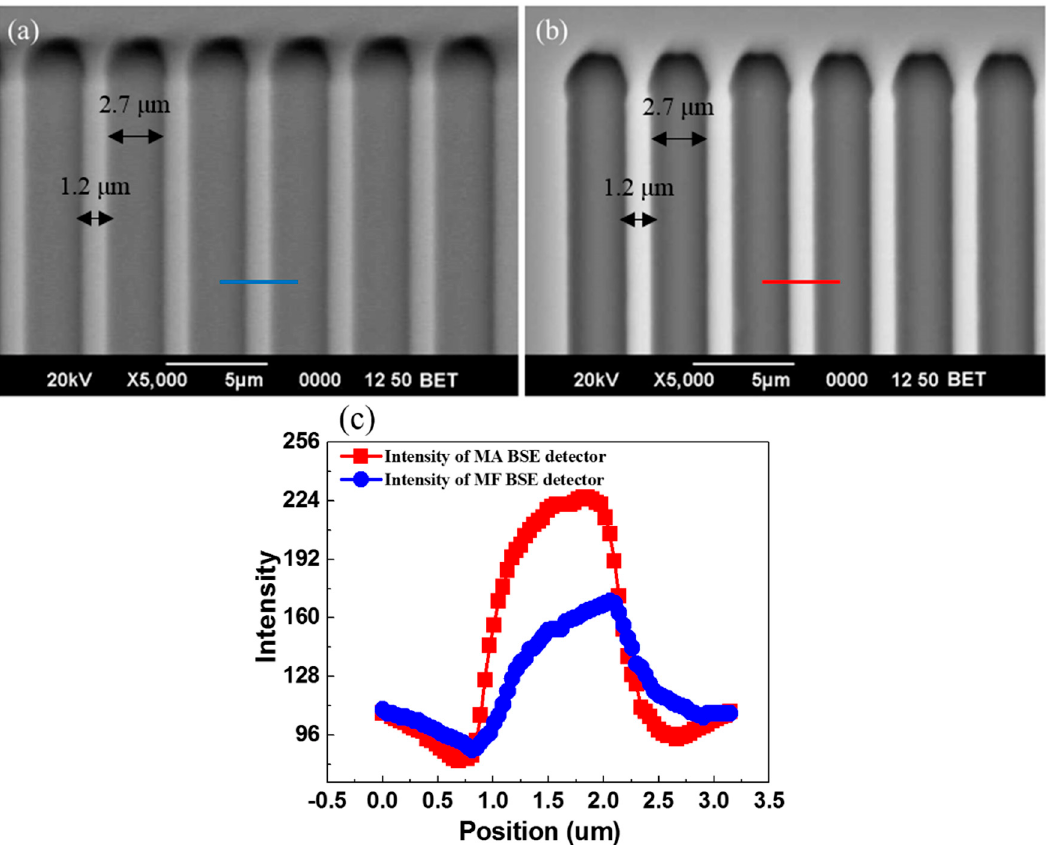
Figure 6. BSEs images of silicon microstructures. The width and depth of silicon micro cavity is 2.7 and 1.0 µ m respectively. The spacing between each strip is 1.2 µ m. BSE image recorded ( a ) with MF BSE detector and ( b ) with MA BSE detector. ( c ) The intensity profiles across the silicon strip in ( a , b ).